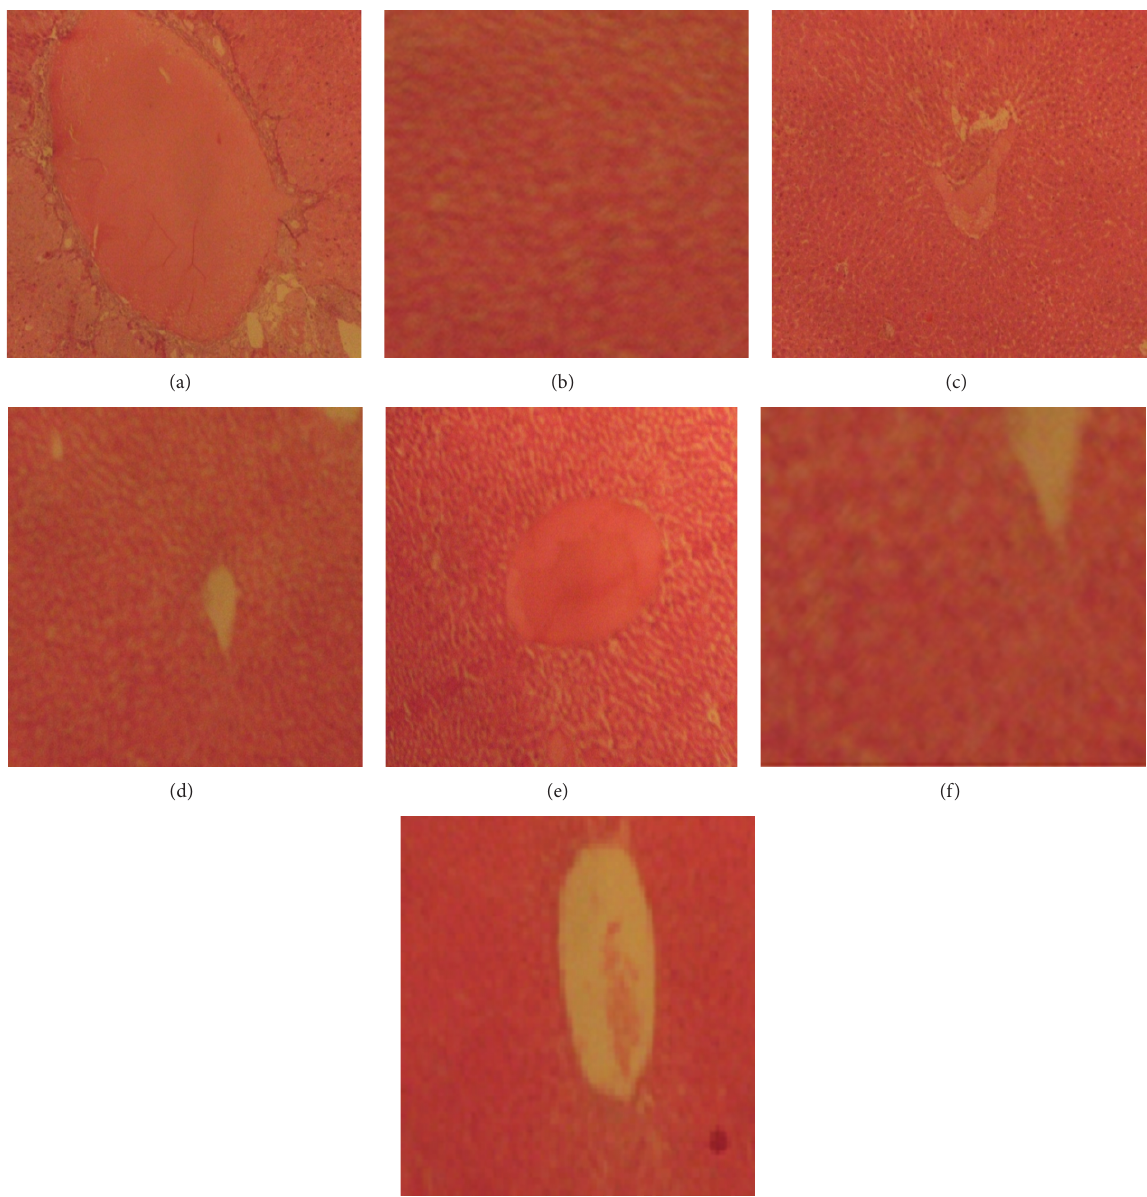
Figure 1: Representative photomicrographs of H&E stained sections of the liver of the rat fed with 2-AAF and plant extracts at 200X magnification. (a) Photomicrograph of the liver of the rat fed with 2-AAF only. (b) Photomicrograph of the liver of the rat fed with distilled water only. (c) Photomicrograph of the liver of rat fed with B. ferruguinea and 2-AAF. (d) Photomicrograph of the liver of rat fed with V. amygdalina and 2-AAF. (e) Photomicrograph of the liver of rat fed with O. gratissimum and 2-AAF. (f) Photomicrograph of the liver of rat fed with L. inermis and 2-AAF. (g) Photomicrograph of the liver of the rat fed with T. procumbens and